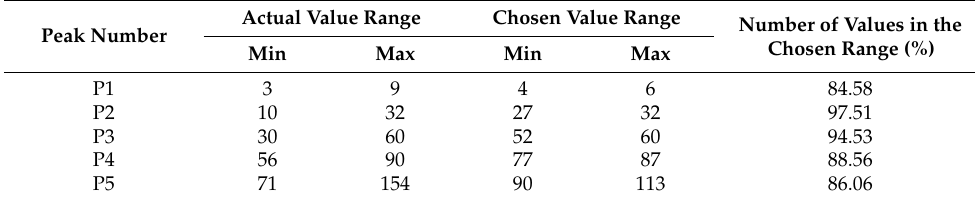
Table 1. Distribution the peak value by frequency range.